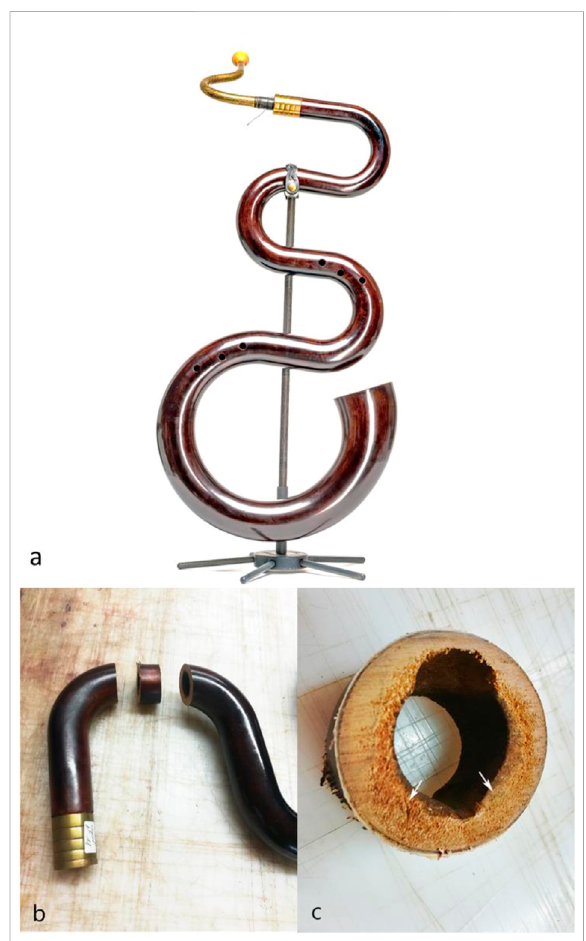
FIGURE 1 (A) Snake-like shape of the serpent helps to position the fi nger holes in reach. (B) European walnut wood samples showing distinctive interior decay were sawn (circle) from the wooden conical tube. (C) Isolations were made from wood chips extracted from the decayed wood (arrows) and placed onto petri dishes with different growth media. Microorganisms were incubated at25 ° C,50% RH(fungus)and at23 ° C,95%RH